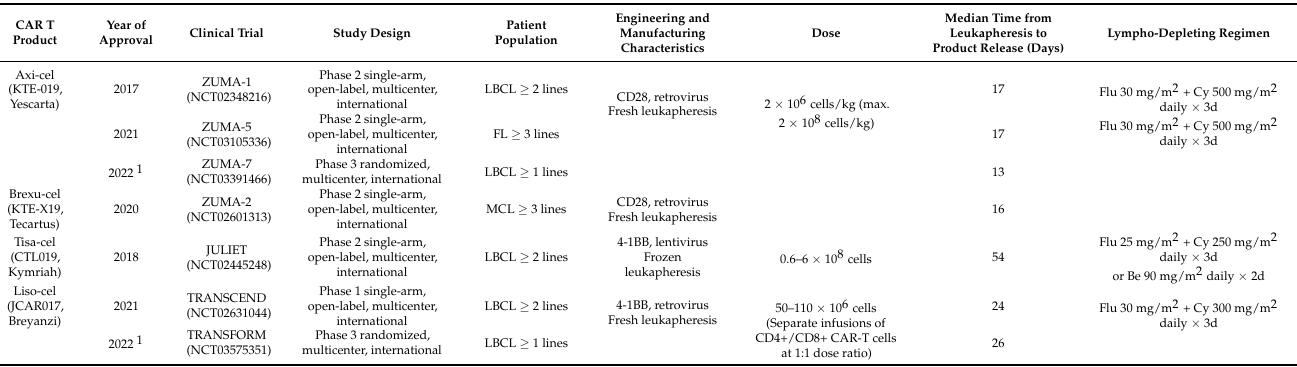
Table 1. Currently FDA-approved CD19 auto-CAR T cell